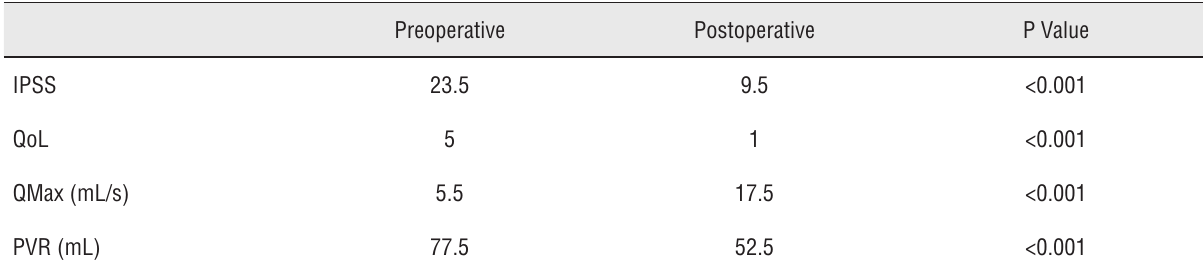
Table 2 - preoperative and postoperative data expressed as median.